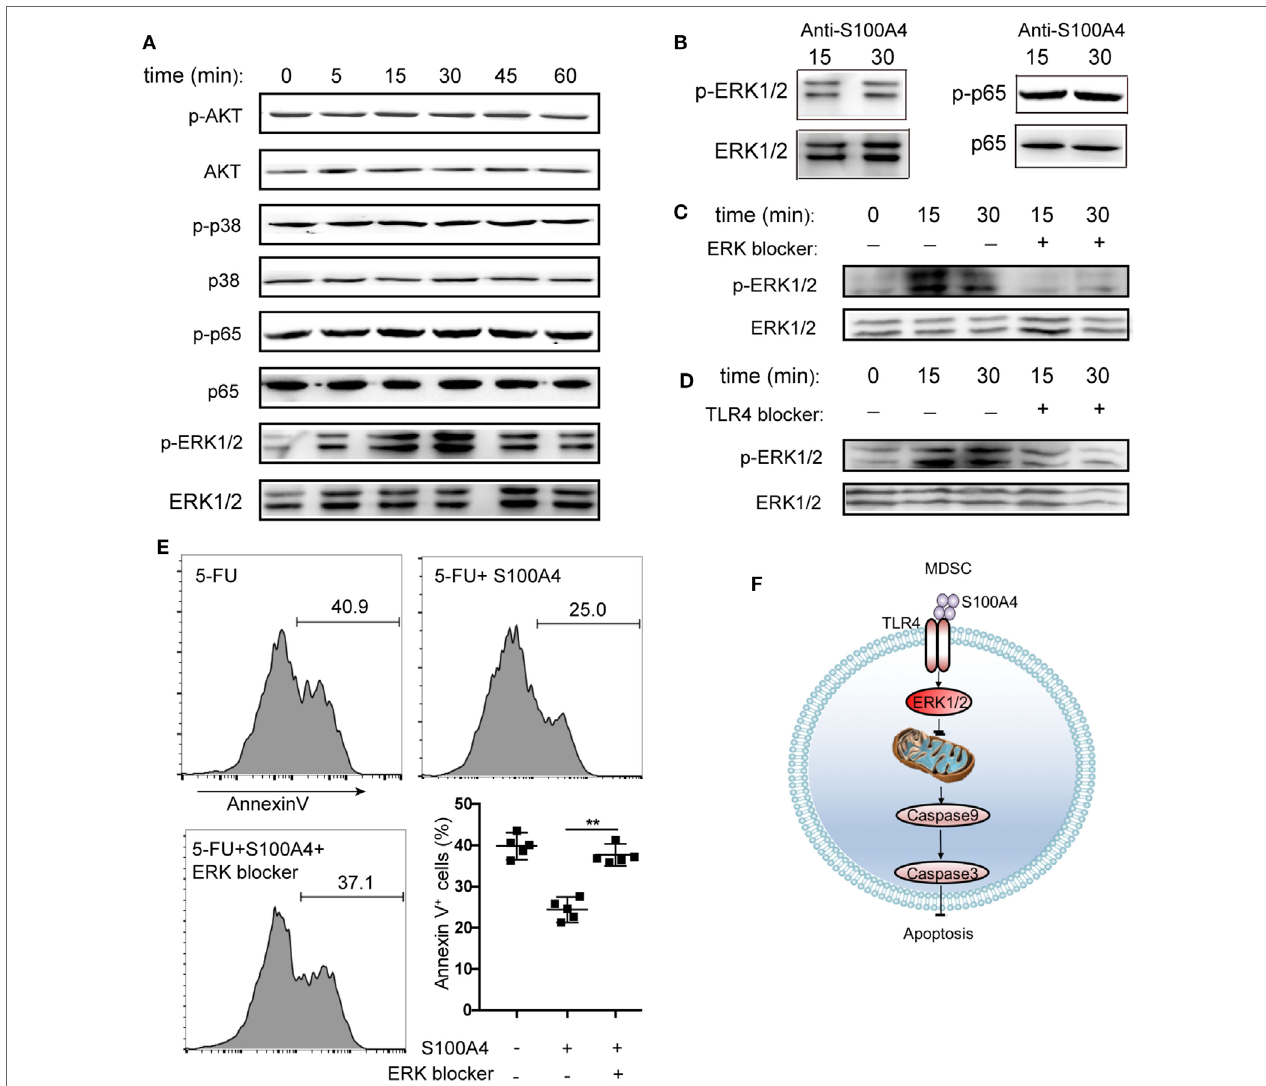
FigUre 6 | Activation of different kinase pathways by S100A4 in myeloid-derived suppressor cells (MDSCs). (a) MSC2 cells were cultured with S100A4 (1 µg/mL) for the indicated durations before phosphorylation of p65 of NF κ B (65 kDa), AKT (56 kDa), p38 (38 kDa), or ERK1/2 (44 kDa, 42 kDa) was determined from cell lysates by western-blot analysis. Respective total protein served as loading control. (B) MCS2 cells were treated with S100A4 (1 µg/mL) in combination with the S100A4 neutralizing antibody, 3B11 (6 µg/mL), and subjected to western-blot analysis for (p-)p65 or (p-)ERK1/2. (c,D) MSC2 cells were treated with (c) extracellular signal-regulated kinase (ERK) (50-nM SCH772984) or (D) toll-like receptor-4 (TLR4) (10-µM VIPER) inhibitors for 30 min before the levels of phosphorylated ERK1/2 were determined from total cell lysates by western-blot analysis. (a–D) Representative results of three independent experiments are shown. (e) MSC2 cells were pretreated with an ERK1/2 inhibitor (50-nM SCH772984) for 30 min before S100A4 (1 µg/mL) was added. Cells were stained with Annexin V and assessed by flow cytometry. Representative results of three independent experiments are shown. Mean and 95% CI, n = 4 per group; ** P < 0.01, Mann– Whitney. (F) Schematic summary for a role of S100A4-recruited TLR4–ERK1/2 signaling in protecting MDSCs from intrinsic apoptosis